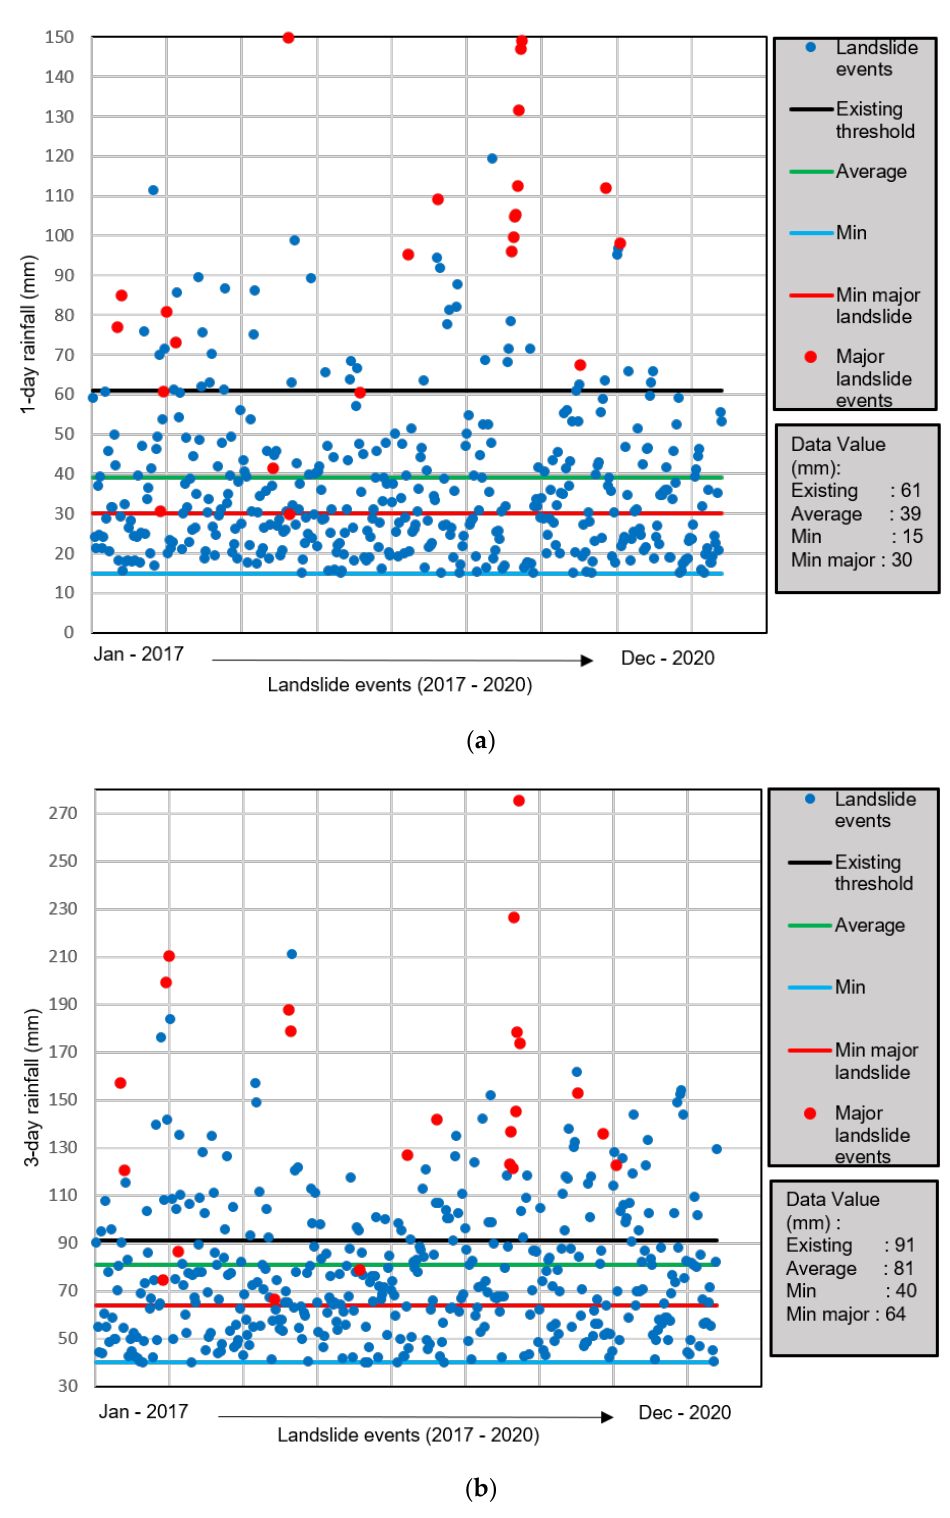
Figure 5. ( a ) One-day cumulative rainfall threshold. ( b ) Three-day effective antecedent rainfall threshold .